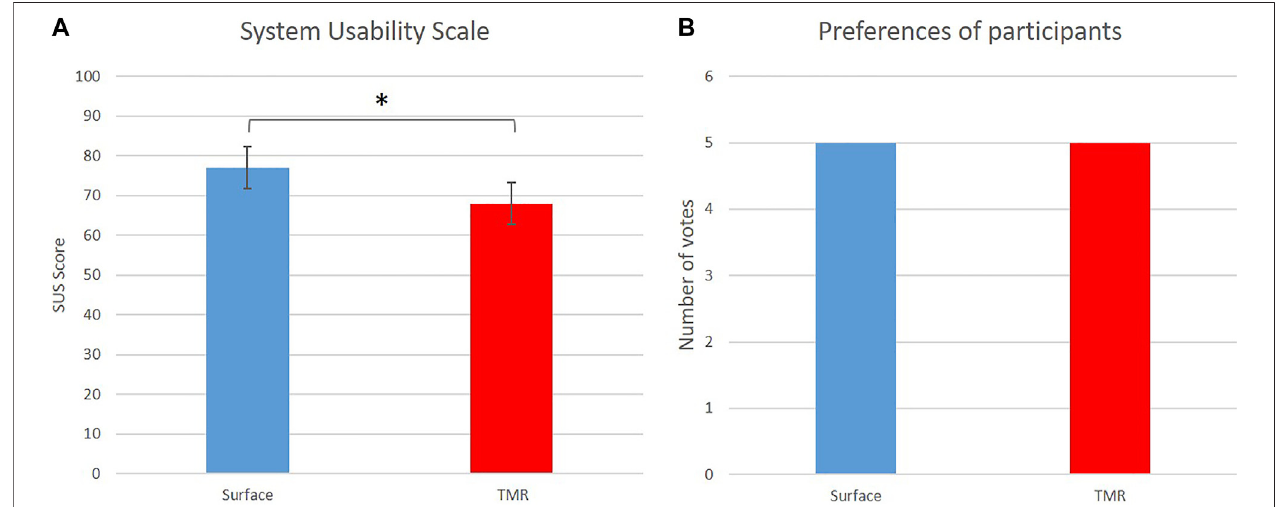
FIGURE 11 | The results of surface gesture and TMR motion gesture ’ s SUS scores with the error bars showing standard error (A) and user preference (B) .